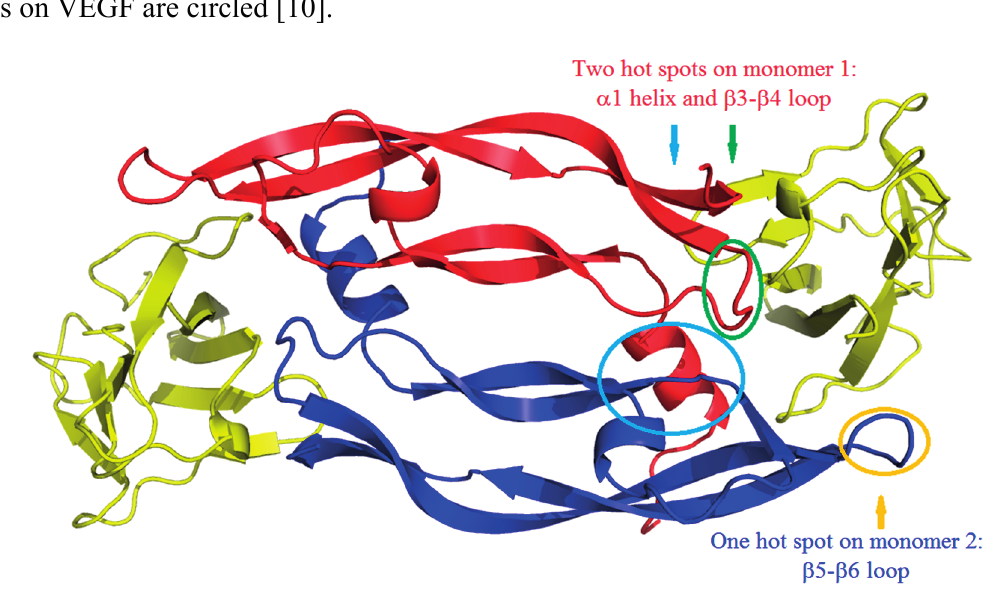
Figure 1. Complex of a VEGF-A dimer with two D2 domains of VEGFR1. The two VEGF-A monomers are presented in red and in blue, the two D2 are in gold. The binding sites on VEGF are circled